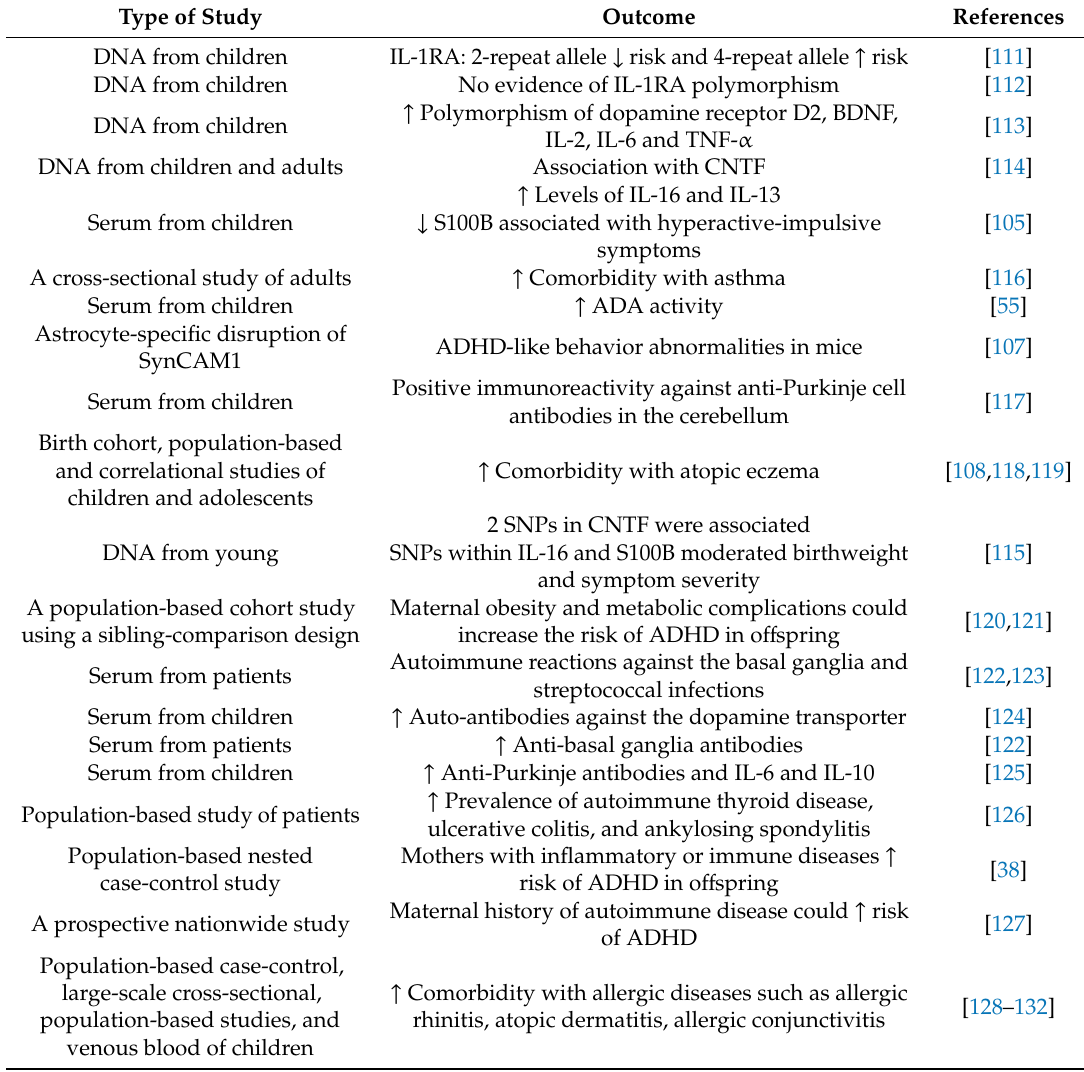
Table 3. Summary of neuroinflammation and outcomes in